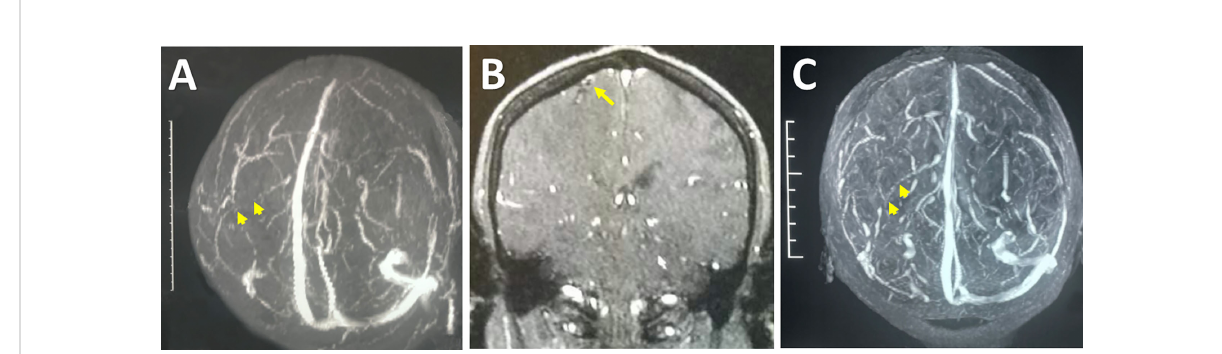
FIGURE 2 Radiological images indicating the ICVT. Preoperative MRV revealed an absence of fl ow (arrowheads) in the left central sulcus vein (A) . Preoperative contrast MRI showed an intraluminal fi lling defect at the site where the deep branch of the right central sulcus vein enters the main trunk (arrow), likely indicative of ICVT (B) . Follow-up MRV showed the recanalization (arrowheads) of the right central sulcus vein after surgical thrombectomy (C)